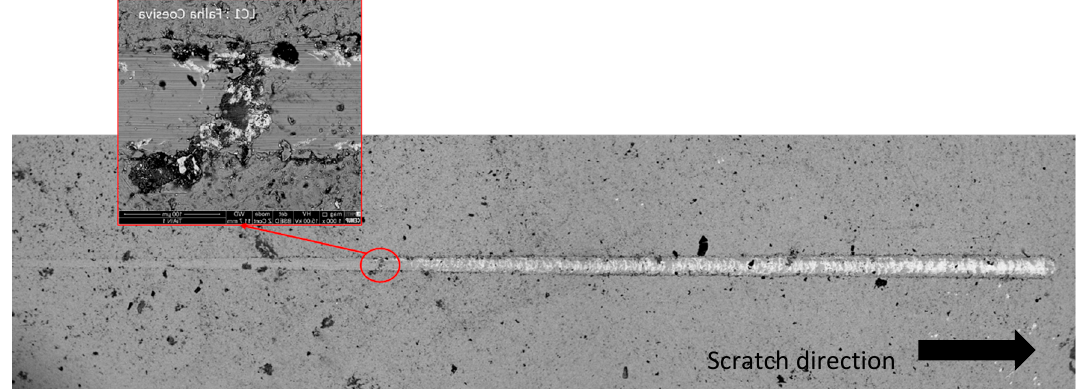
Figure 9. SEM image of one of the three TiAlN coating scratches produced during the scratch tests.